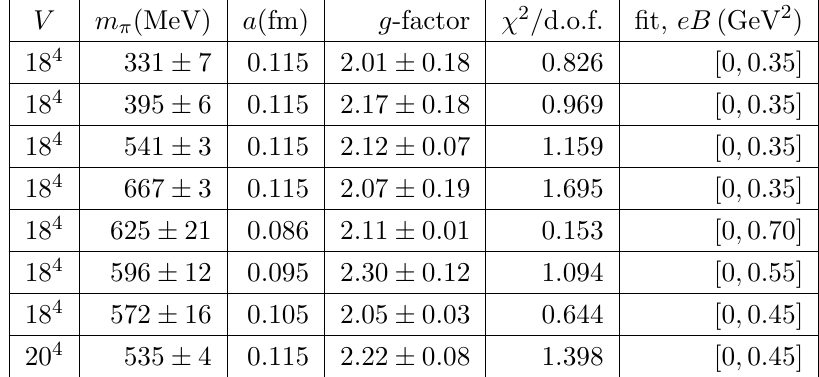
Table 1. The g-factor of (cid:26) (cid:6) meson for the various lattice volumes, the pion masses and the lattice spacings, the nonrenormalized quark masses are also shown. The values of (cid:31) 2 /d.o.f. and (cid:12)tting intervals are also represented.